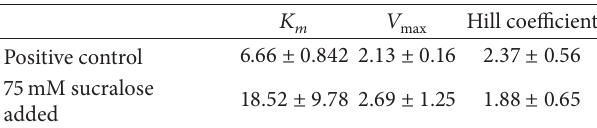
Table 2: Invertase reaction rate kinetic constants from Figure 5. 𝑉 max units in change in absorbance per minute and Km in mM. The values are means +/ − 1SEM (𝑛 = 5)